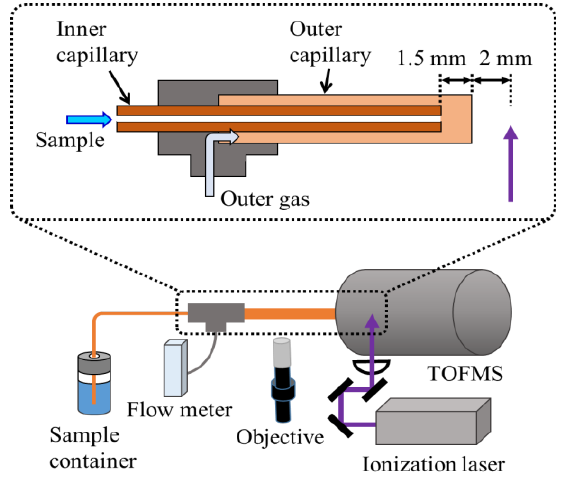
Figure 1. Schematic diagram of the apparatus. An enlarged view of a pair of concentric capillary columns for sample introduction is also shown.